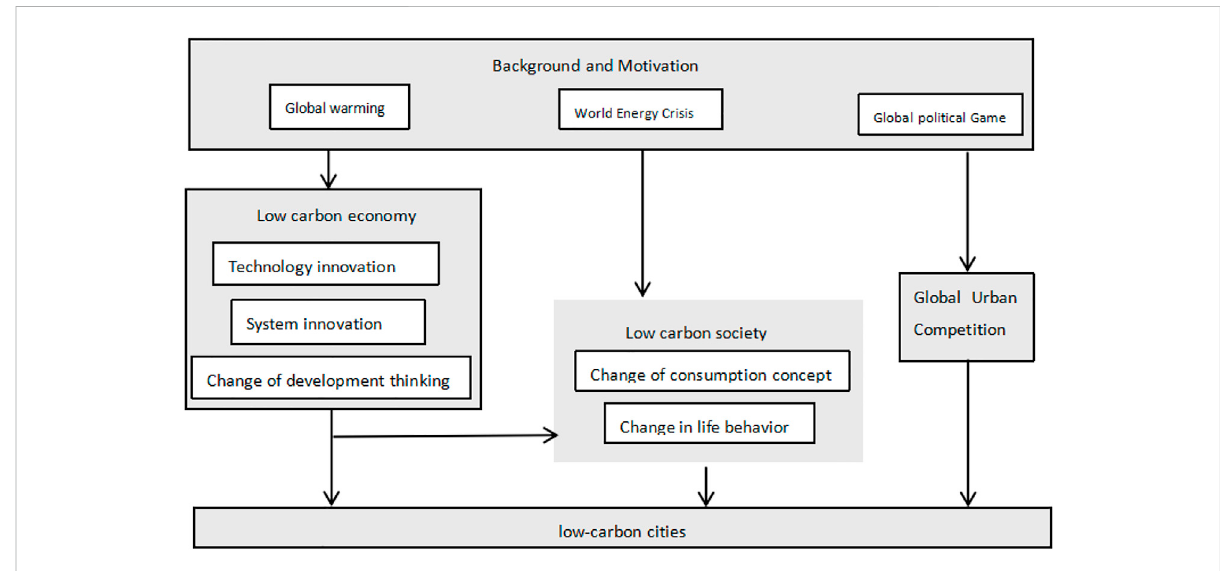
FIGURE 1 The formation and connotation of a low-carbon city. Source: According to the literature of Cheng et al.